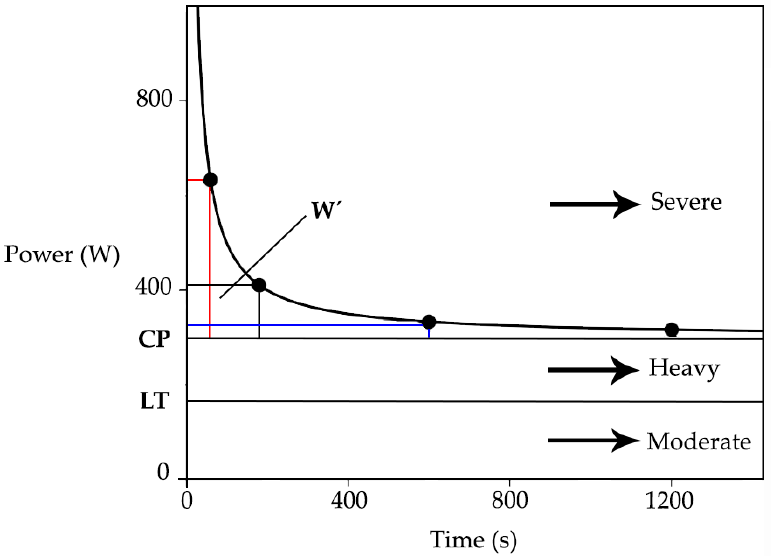
Figure 1. The power–time (P-t) relationship for high-intensity exercise W’ is constant, but may be utilized at different rates depending on the proximity of the exercise PO to the CP [5]. W´ is measured in kilojoules (kJ) and is a function of the oxygen uptake (VO 2 ) slow component; meaning a slow increase in the VO 2 during con- stant work performed above the lactate threshold [6]; maximal oxygen uptake (VO 2max ); the depletion of intramuscular substrates, such as muscle creatine phosphate; and the gly- cogen, and the accumulation of metabolites (hydrogen ions, adenosine diphosphate, phosphate ions), which is associated with impaired muscle contractile function [7]. The CP represents an important parameter of an aerobic function. It can provide an even more meaningful criterion based on the measure of external PO and time than the lactate thresh- old or the maximal uptake of oxygen (O 2 ) [3,8]. Rather than using equivalent exercise in- tensities relative to these metabolic parameters (lactate threshold, VO 2max ), setting exercise intensity relative to CP combines systemic and intramuscular response, and the W´ is ex- pended above the CP, VO 2max is attained, and intolerance is manifested. The CP occurs approximately at 70–80% VO 2max and trained individuals can reach 80–90% VO 2max [4].